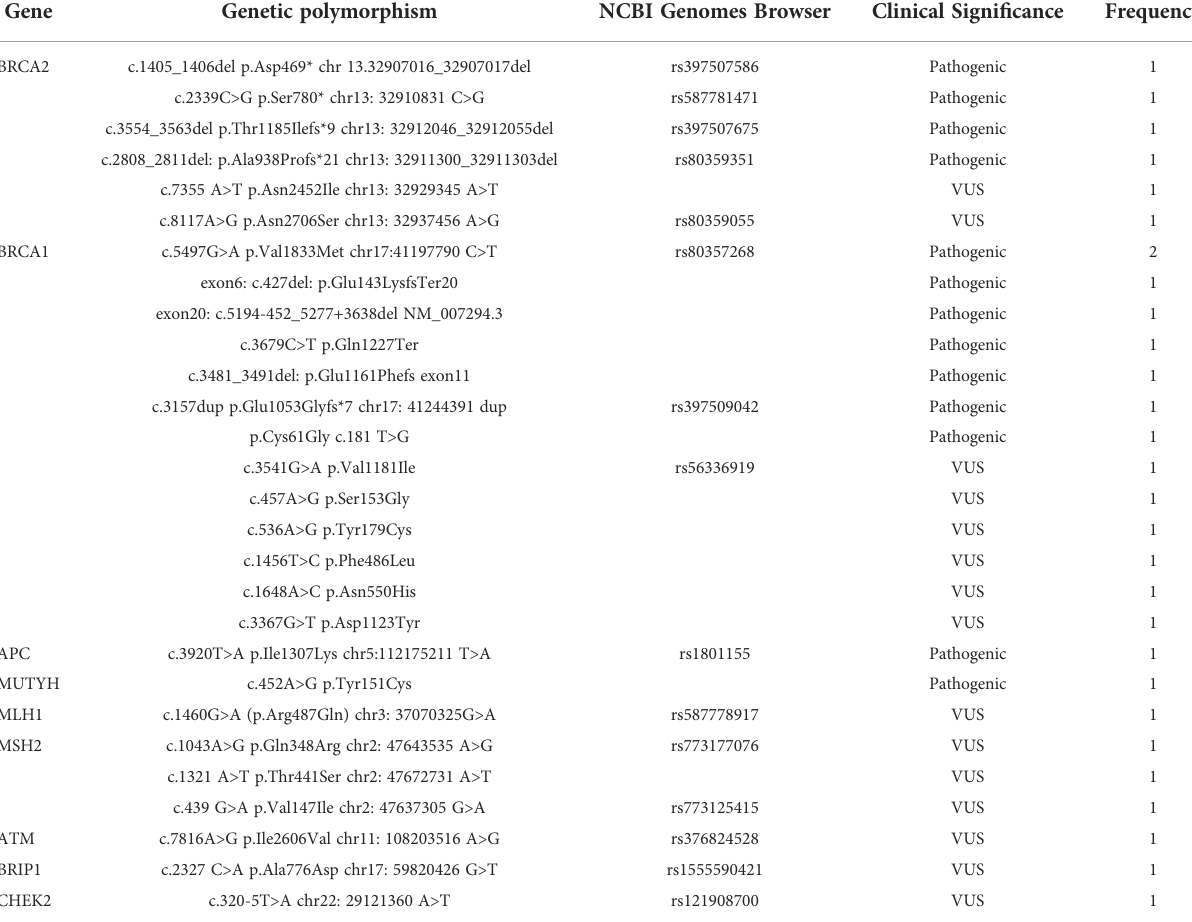
TABLE 3 Germline mutations in patients with HGSC.